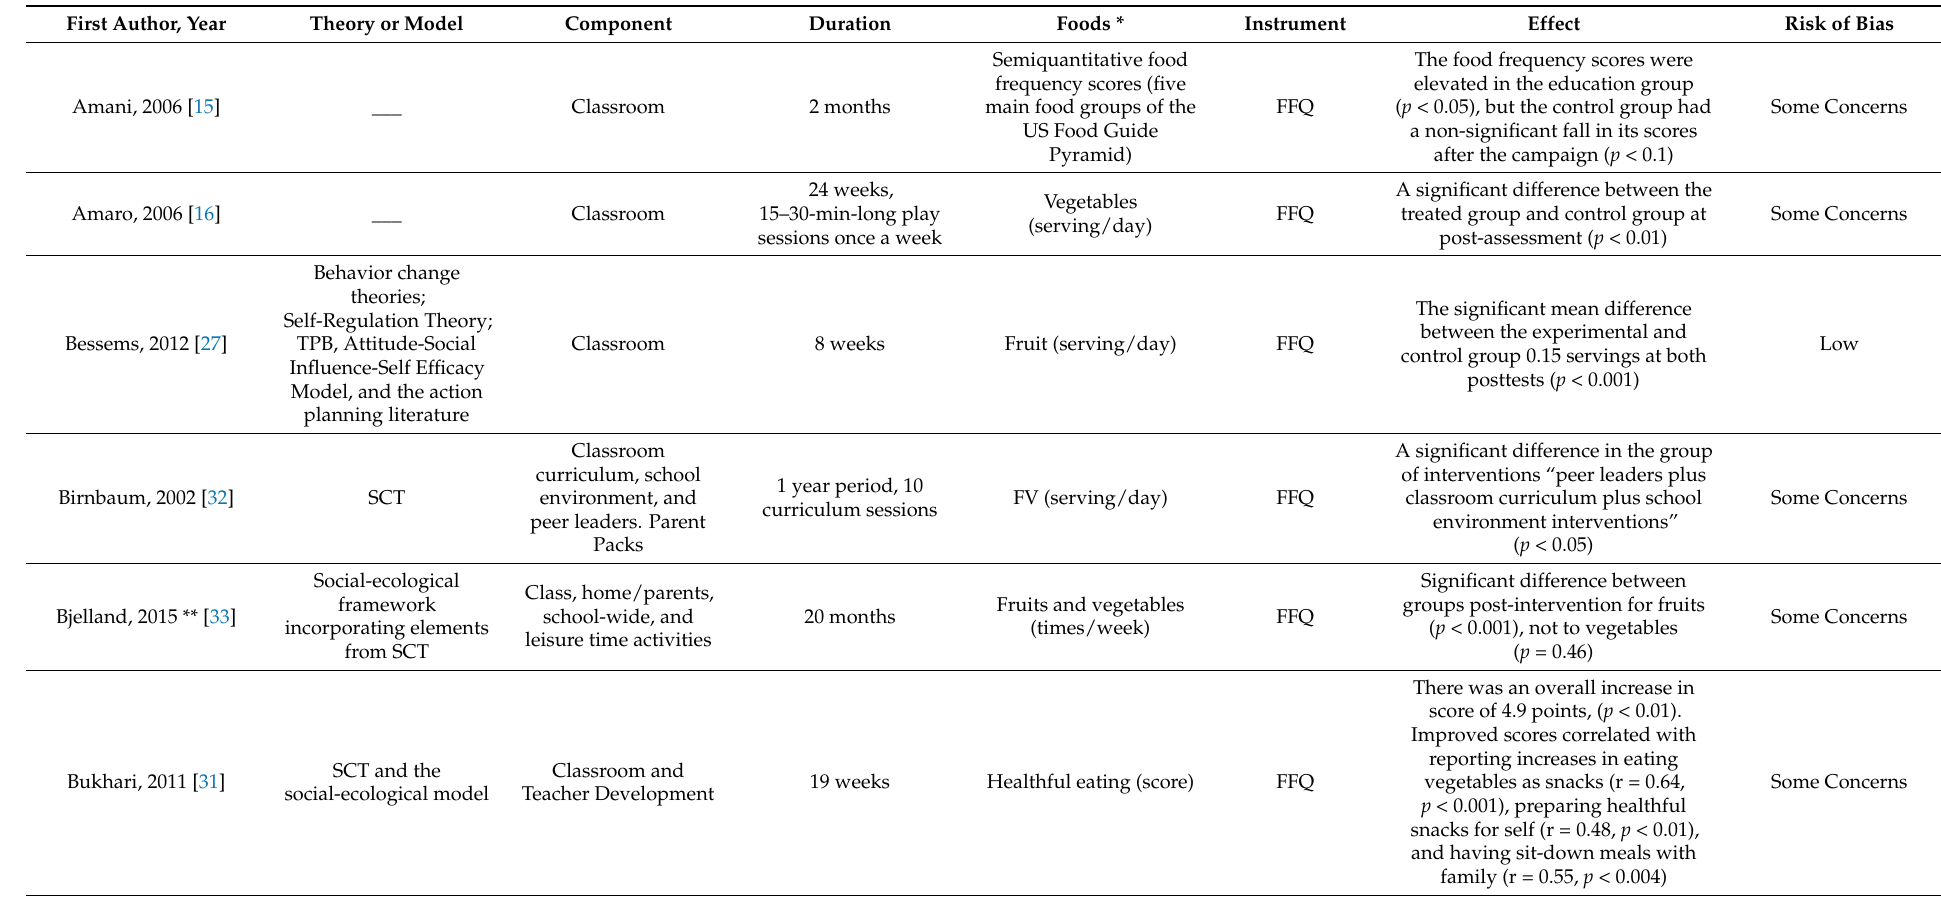
Table 1. Summary of school-based food and nutrition education intervention